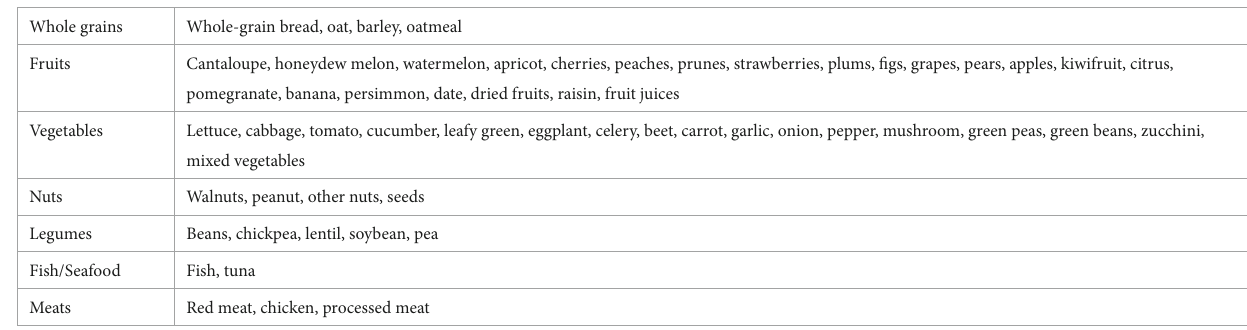
TABLE 1 Food items included in food groups contributing to the Mediterranean diet